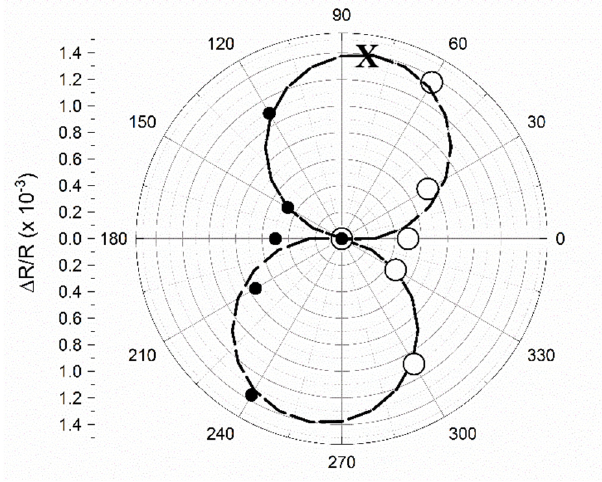
Figure 2. Reflectance anisotropy spectroscopy (RAS) azimuthal analysis used to find the preferential anisotropy direction. The reported angle represents the misalignment between the RAS α direction and the exfoliation direction used in the substrate preparation. The open dots are experimental data, while the filled ones are symmetrically equivalent data reported only for a better comparison